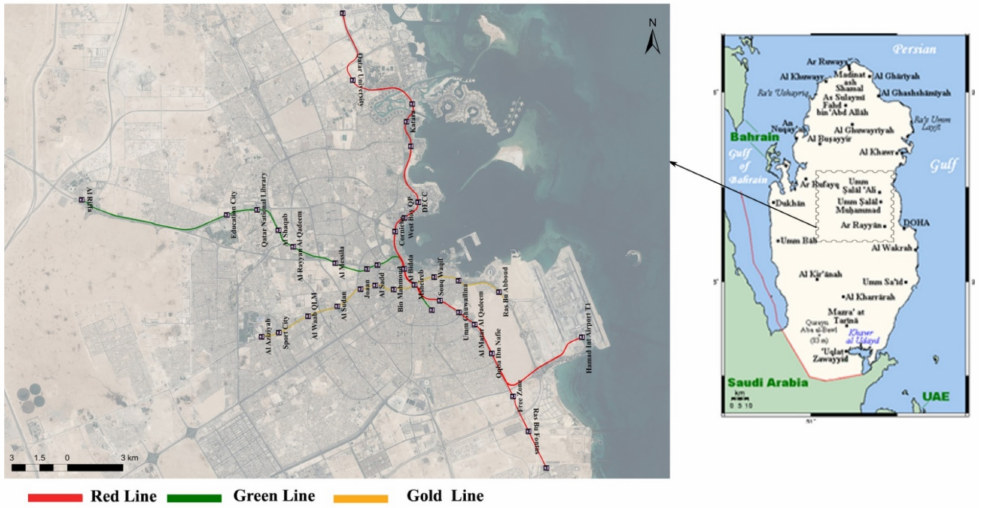
Figure 6. Doha operational metro